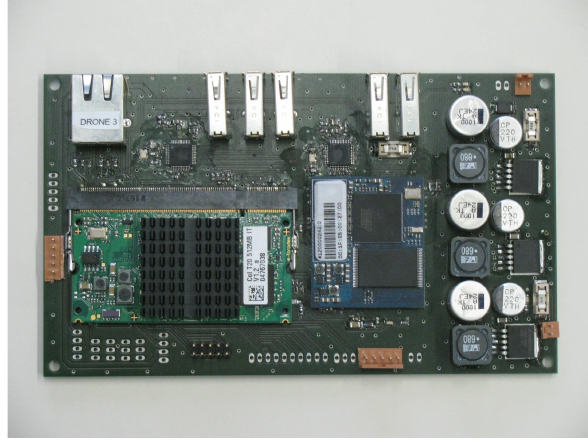
Figure 1. Embedded System of the sensor package